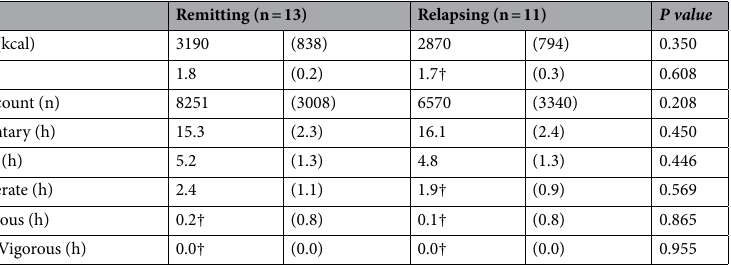
Table 4. Estimated total energy expenditure (TEE), physical activity level (PAL), and mean daily activity rate and duration of participants in Crohn’s Disease relapse or remission. PAL, physical activity level; h, hours. † not normally distributed (Shapiro–Wilk p < 0.05). Age 20-73y. Sedentary = < 1.5 METs (Metabolic Equivalents); Light = 1.5–2.9 METs; Moderate = 3.0–5.9 METs; Vigorous = 6–8.9 METs; Very Vigorous = ≥ 9 METs. Data are presented as mean (SD) or median